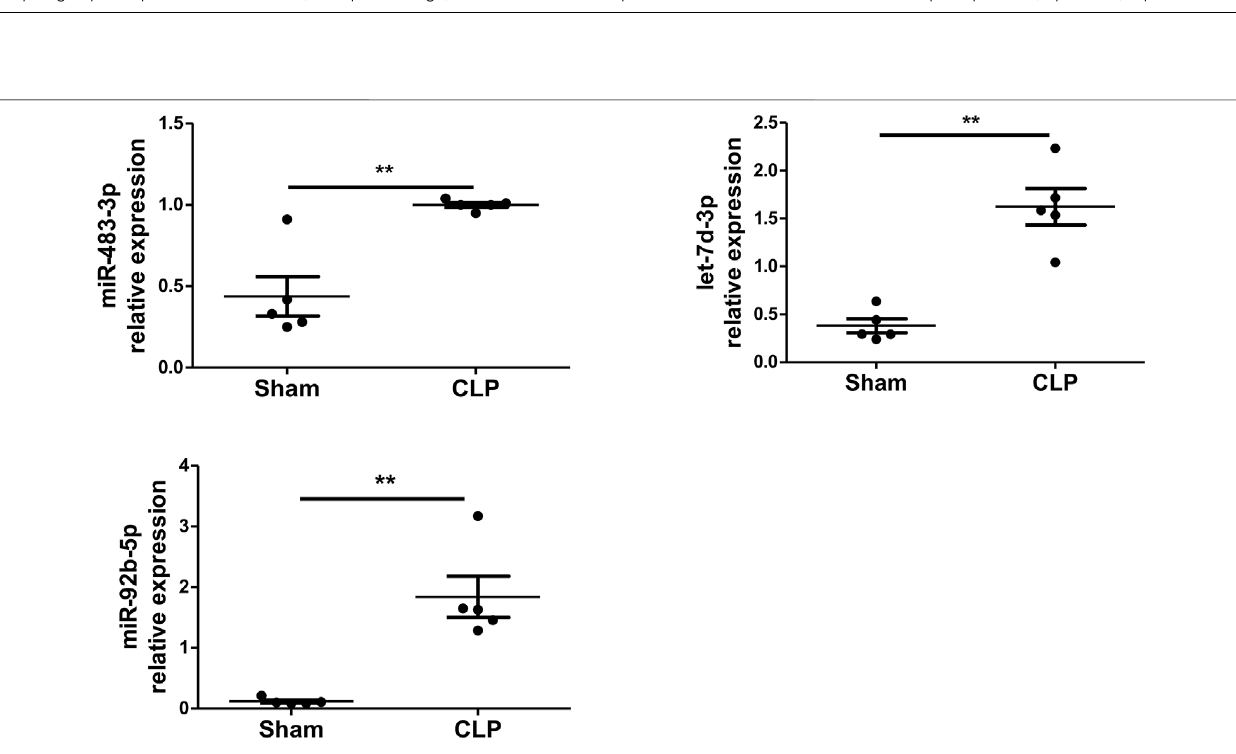
Frontiers in Molecular Biosciences |